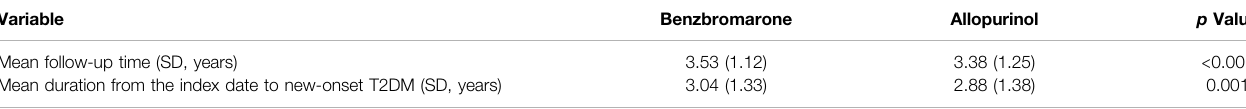
TABLE 3 | Mean follow-up time and mean duration from the index date to new-onset type 2 diabetes mellitus (T2DM). Variable